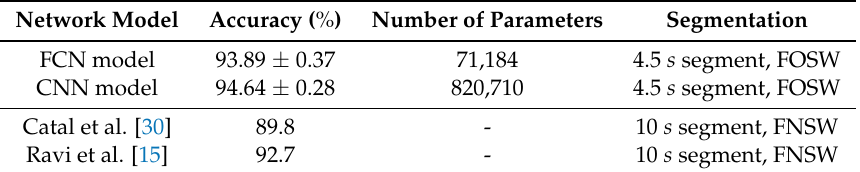
Table 2. Results of activity